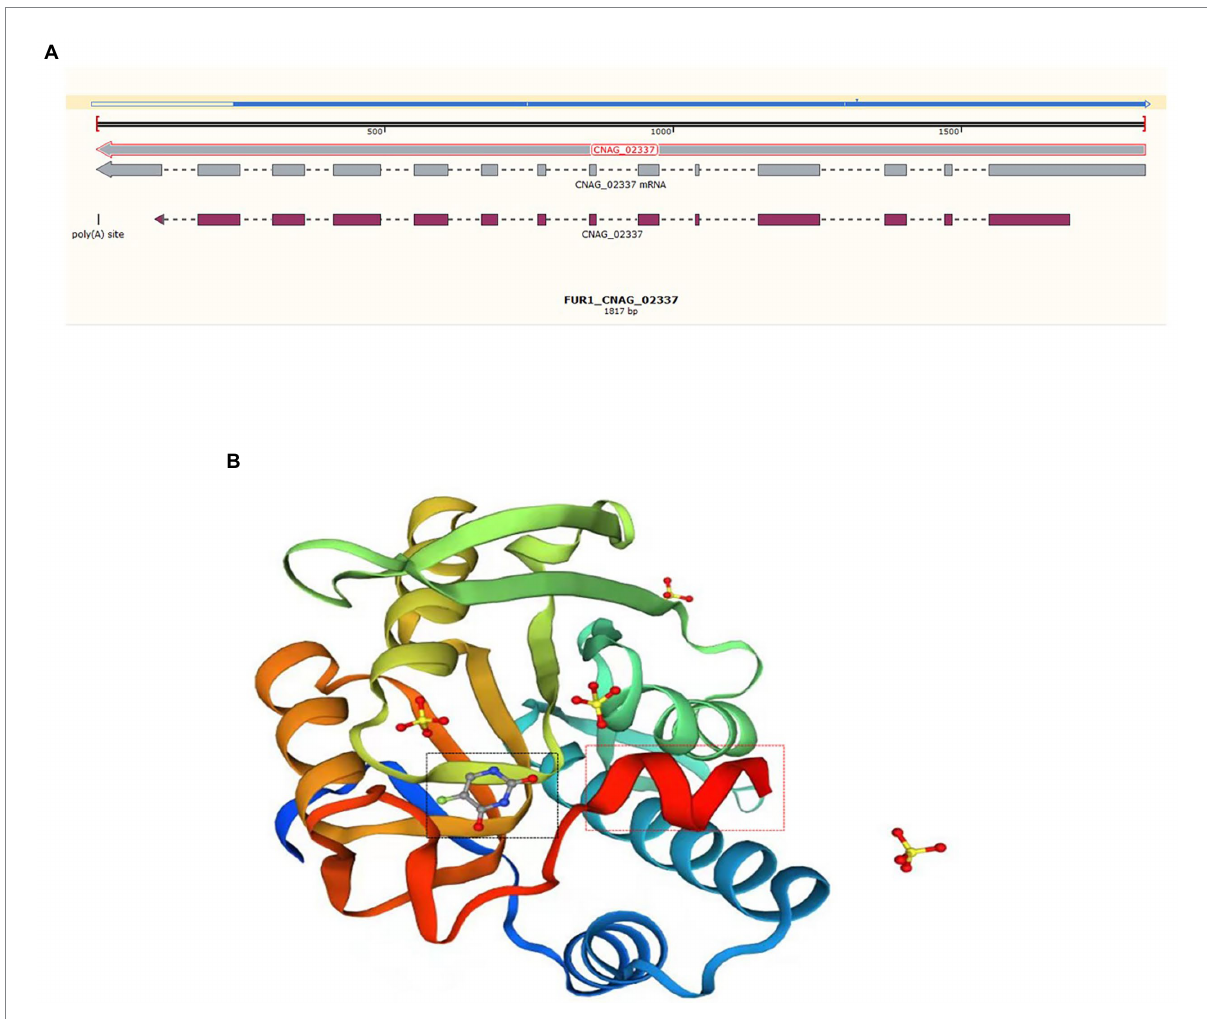
FIGURE 3 Sequence alignment and protein structure of FUR1. ( A) DNA sequence alignment of the FUR1 gene of ZY011 and the reference sequence (CNAG_02337). The blue line above refers to the sequence of ZY011, and the different sequences are illustrated with a hollow line. The gray line is representative of the reference sequence of the gene and mRNA, and the mauve line represents the exons. (B) We revealed the protein structure of FUR1 , and the different sequences are highlighted with red rectangles. This region is near the 5-FU-binding site (black